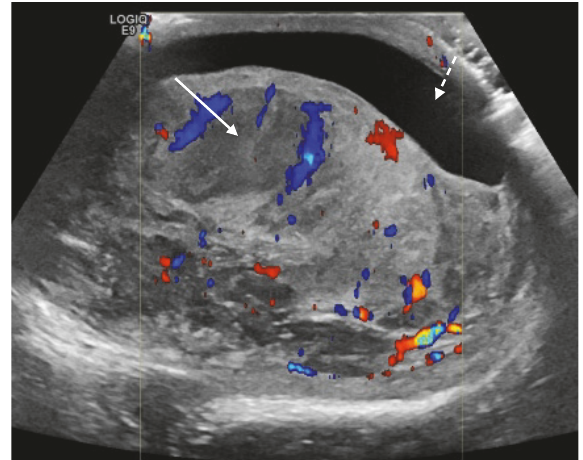
Figure 1: Ultrasound of the scrotum demonstrates an enlarged, heterogeneous, hypervascular right testicle and epididymis with focal, relatively hypovascular hypoechoic areas in the testicular parenchyma (white arrow) and an associated small hydrocele (dashed white arrow).